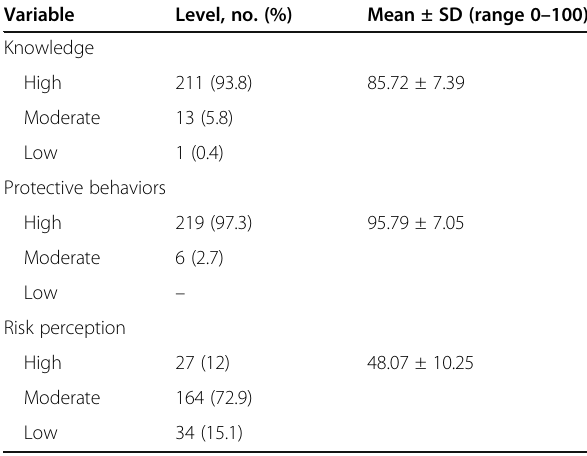
Table 2 COVID-19-related knowledge, protective behaviors,